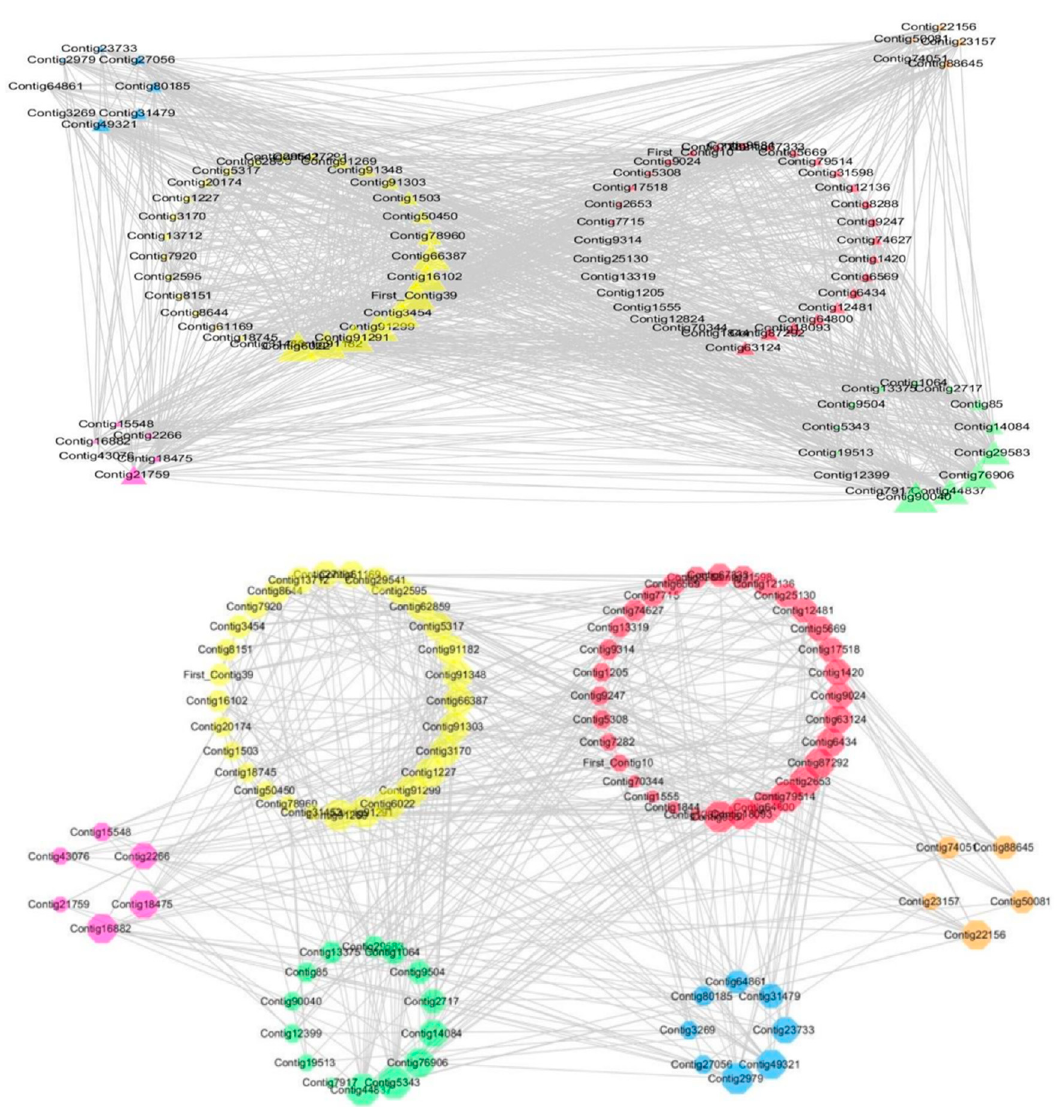
Figure 3. GCN of carbohydrate metabolism genes and flower differentiation, auxin, gibberellin, cold, and methylation-related genes. Different colored nodes represent different types of genes and the edges represent pairwise relations between genes. Yellow nodes: flower differentiation genes; red nodes: sugar transport genes; purple nodes: Gibberellin genes; green nodes: Auxin genes; blue nodes: methylation genes; orange nodes: cold genes. The correlation coefficient of the figure above was 0.95 and the figure below was 0.95.